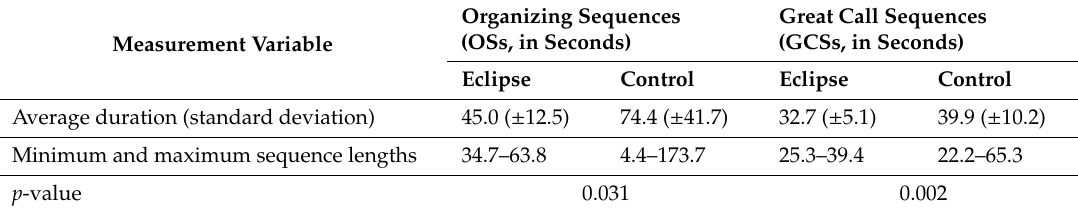
Table 3. Quantitative observations of the durations of organizing and great call sequences performed by siamangs during the day of the eclipse and during nine control bouts. p -values are derived from a two-tailed t -test between eclipse bouts and control